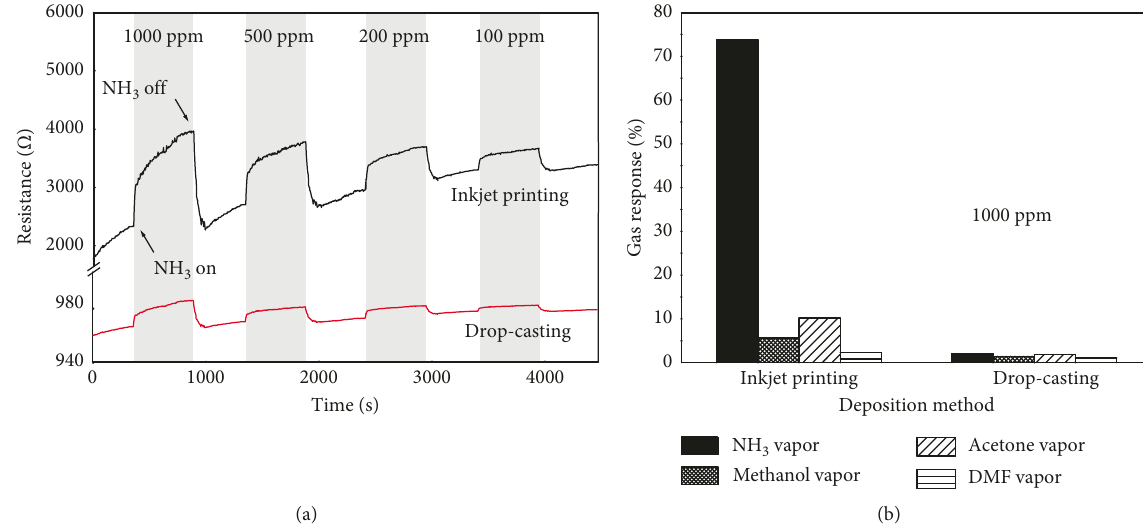
Figure 9: (a) Resistance changes of the fabricated gas sensors prepared by drop-casting and inkjet printing exposed to NH concentrations. (b) Gas response of sensor exposed to various VOCs with a fixed concentration of 1000ppm.